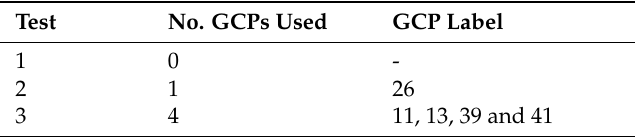
Table 5. Test configurations without or with GCPs (“-” stands for no GCP